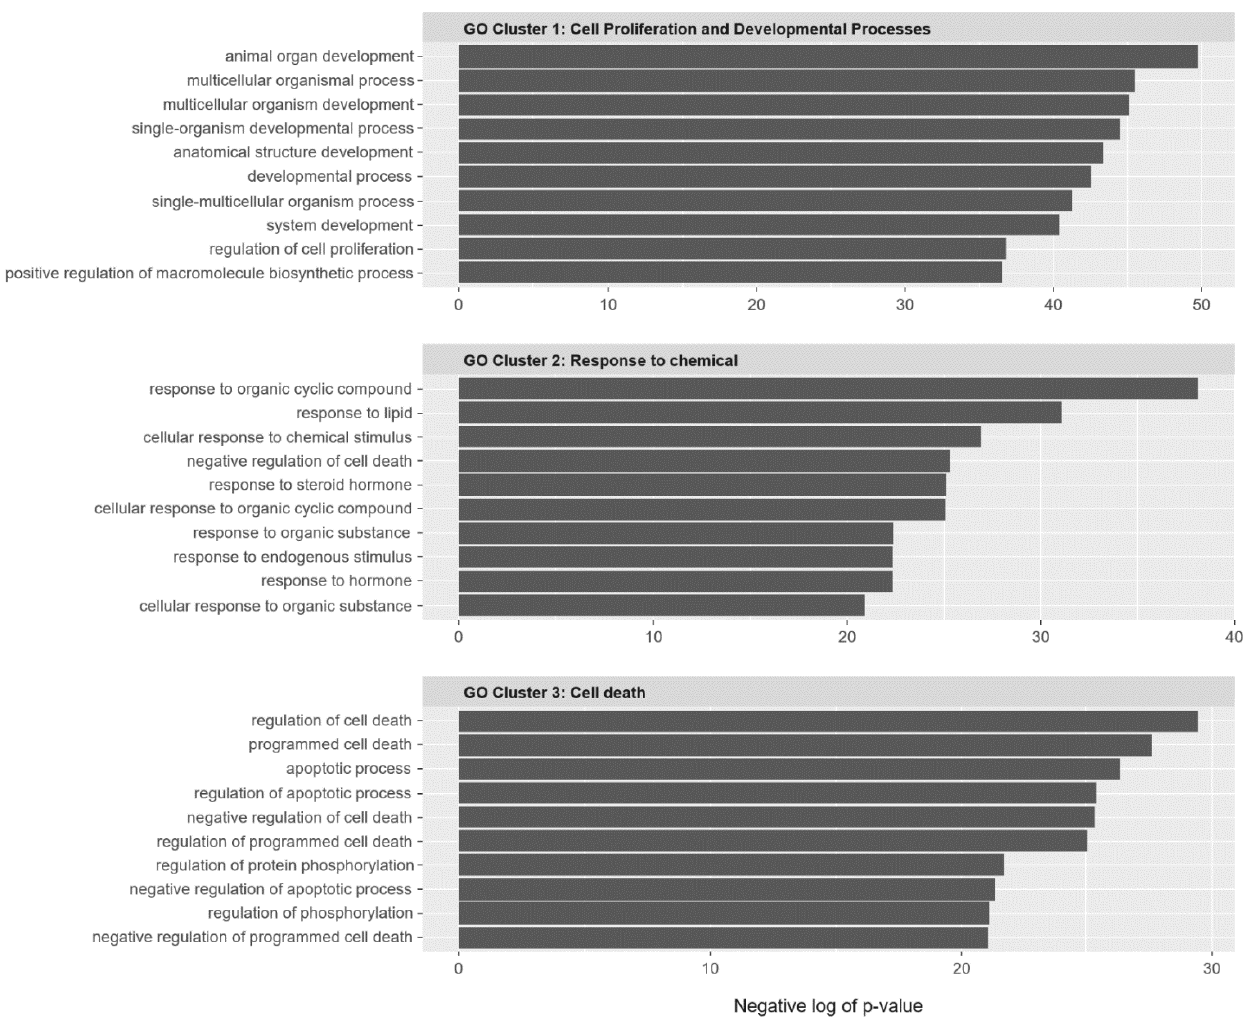
Figure 3. Functional enrichment analysis of the Kyoto Encyclopedia of Genes and Genomes (KEGG) pathway and gene ontology for 95 genes involved in synthetic cytotoxic interactions. These genes were significantly enriched in terms related to cell death and response to chemical and biological processes.